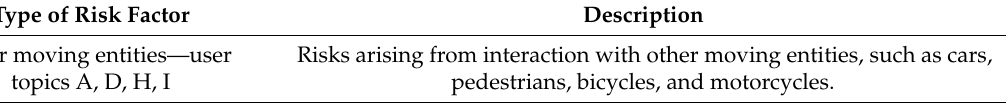
Table 7. Summary of the risk factors experienced by electric kick scooter users.